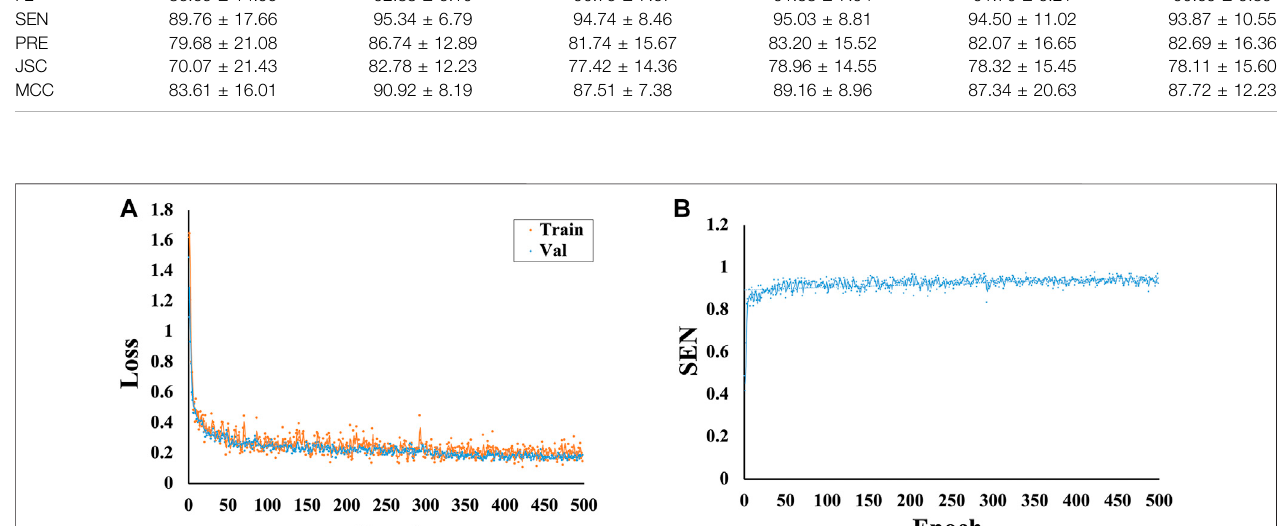
FIGURE4| VariationsinthelossandSENvaluesatdifferentepochs. (A) Variationsinthelossvaluesatdifferentepochs. (B) VariationsintheSENvaluesatdifferent epochs.